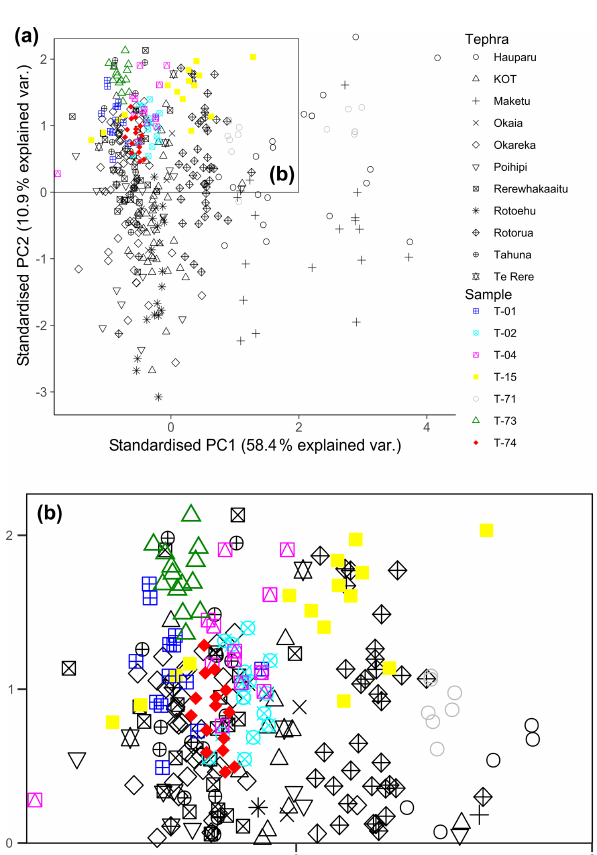
Figure 3. (a) PCA individuals of reference tephra EMPA data (in black symbols from Lowe et al., 2013; Molloy et al., 2009) and Orakei samples (in coloured symbols). (b) Enlarged inset from (a) . Symbols and references as in (a)